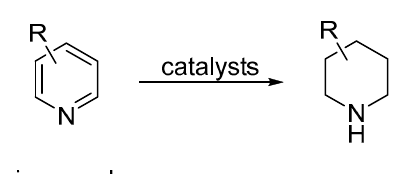
Table 1. Optimization of reaction conditions a .